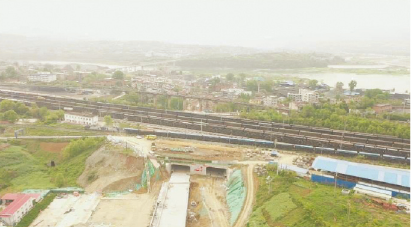
Figure 1: Schematic diagram of the tunnel undercrossing the existing railway line.